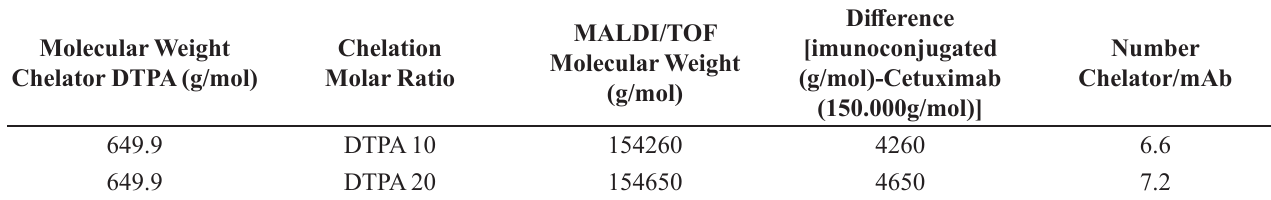
TABLE II - Determination of number of chelators per antibody by spectrometry Autoflex MALDI-TOF/TOF